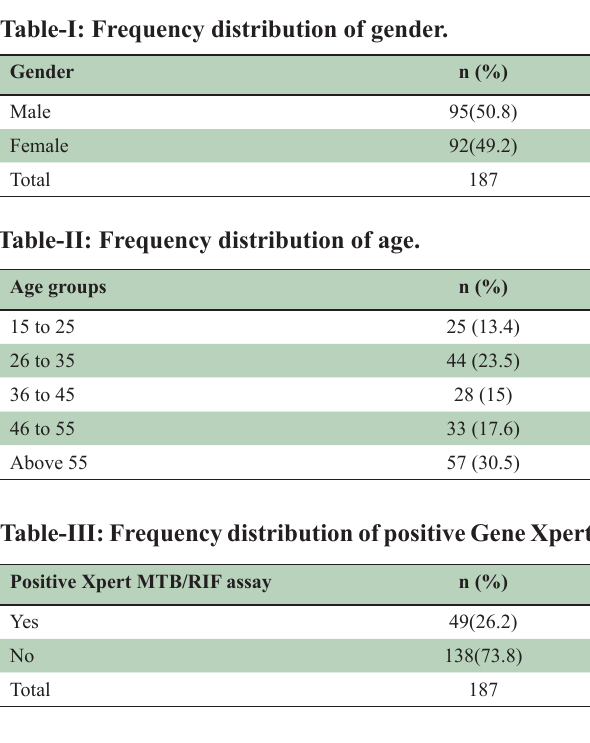
Table-III. Among patients, 72(38.5%) patients had diabetes